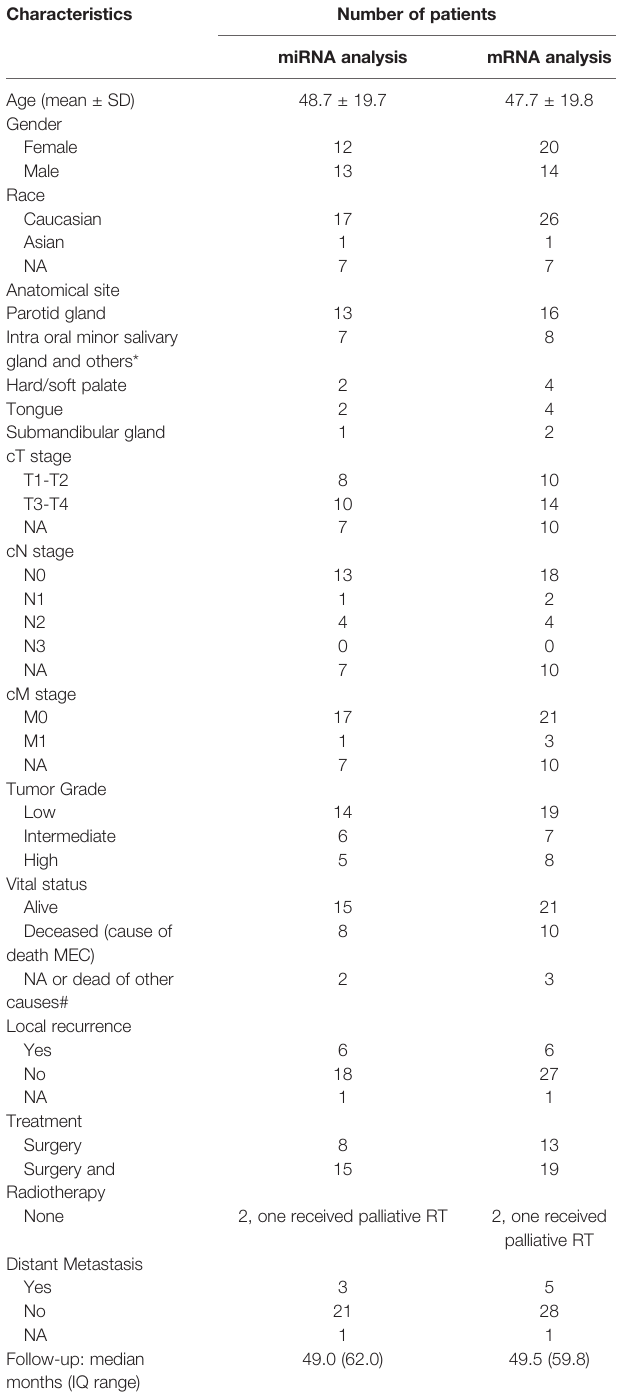
TABLE 1 | Demographic, clinical histopathological, therapeutic and follow-up fi ndings of 35 mucoepidermoid carcinomas patients evaluated by mRNA and miRNA expression